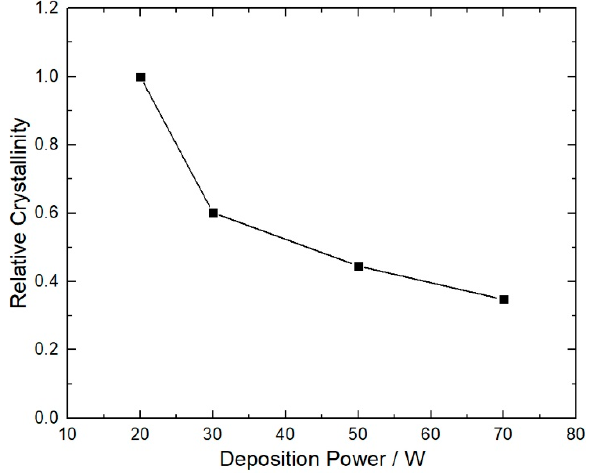
Figure 2. XRD patterns of the Bi 2 Te 3 films deposited under different powers.